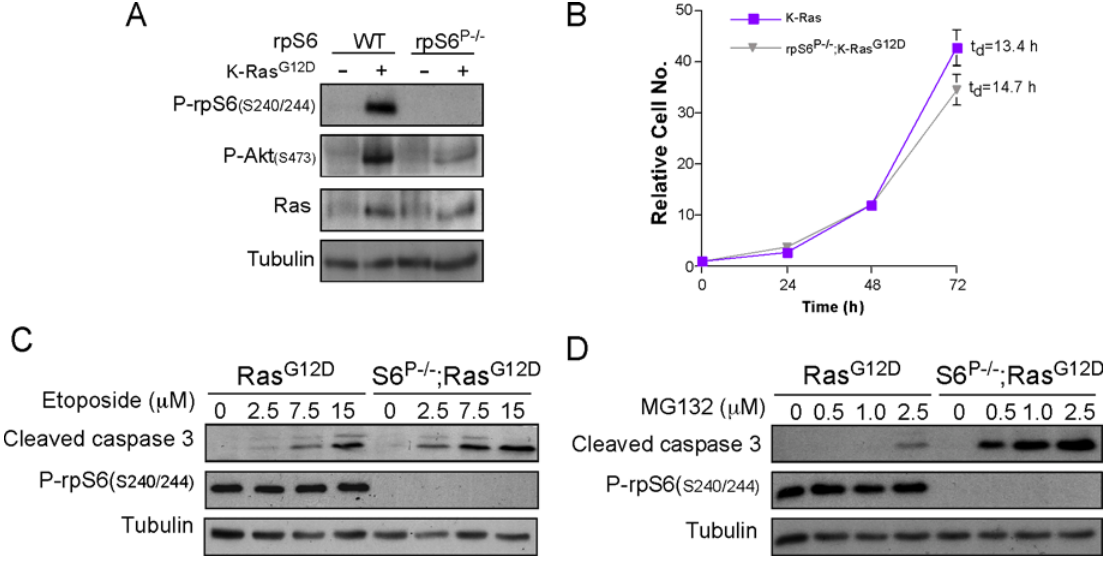
Fig 4. rpS6 phosphorylation deficiency renders Ras G12D MEFs more sensitive to both genotoxic and proteotoxic stresses. (A) Immortalized WT, rpS6 P-/- , Ras G12D and rpS6 P-/- ;Ras G12D MEFs were harvested and their cytoplasmic proteins were subjected to Western blot analysis with the indicated antibodies. (B) Ras G12D and rpS6 P-/- ;Ras G12D MEFs were seeded in 96-well plates at a density of 4 x10 3 per well. Proliferation was monitored by measuring the A 650 of the methylene-blue dye extracted from stained cells [32]. Absorbance measured 24 h after platting, was set arbitrarily at 1 and absorbance measured at later time points (average ± SEM [n = 6]) for each time point) was normalized to that value. t d , population-doubling time. (C) Immortalized Ras G12D and rpS6 P-/- ;Ras G12D MEFs were incubated with the indicated concentrations of etoposide for 24 h, harvested and their cytoplasmic proteins were subjected to Western blot analysis with the indicated antibodies. (D) Immortalized Ras G12D and rpS6 P-/- ;Ras G12D MEFs were incubated with the indicated concentrations of MG132 for 24 h, harvested and their cytoplasmic proteins were subjected to Western blot analysis with the indicated antibodies.